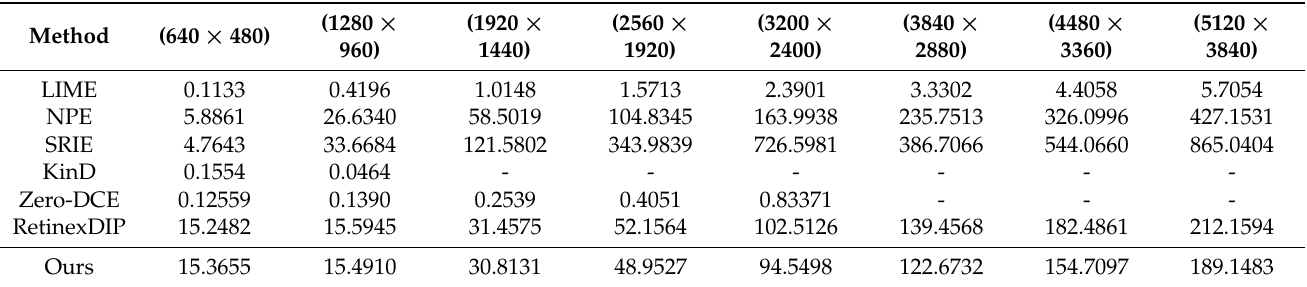
Table 4. Runtime (RT) comparison (in